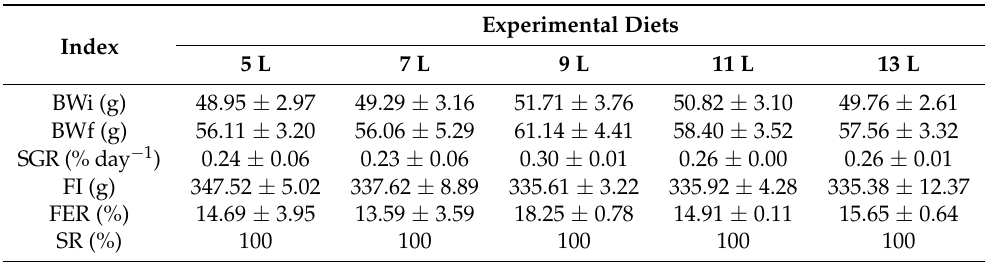
Table 4. The effect of dietary crude lipid levels on growth and feed efficiency parameters of Onychos- toma macrolepis broodfish.